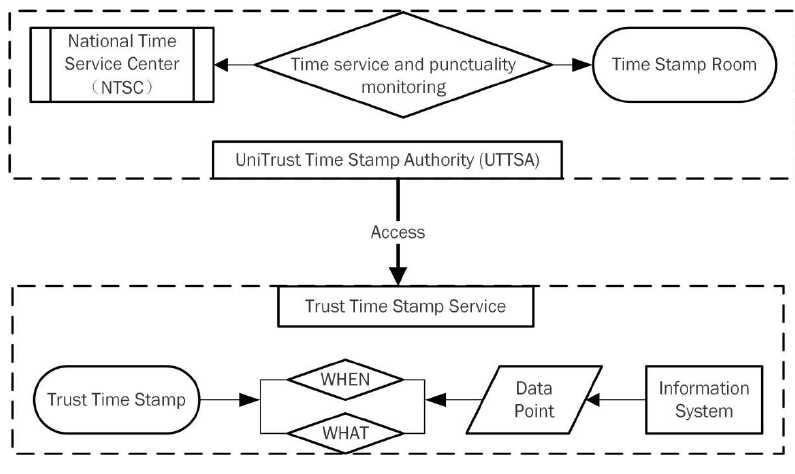
Fig. 2 Timestamp service